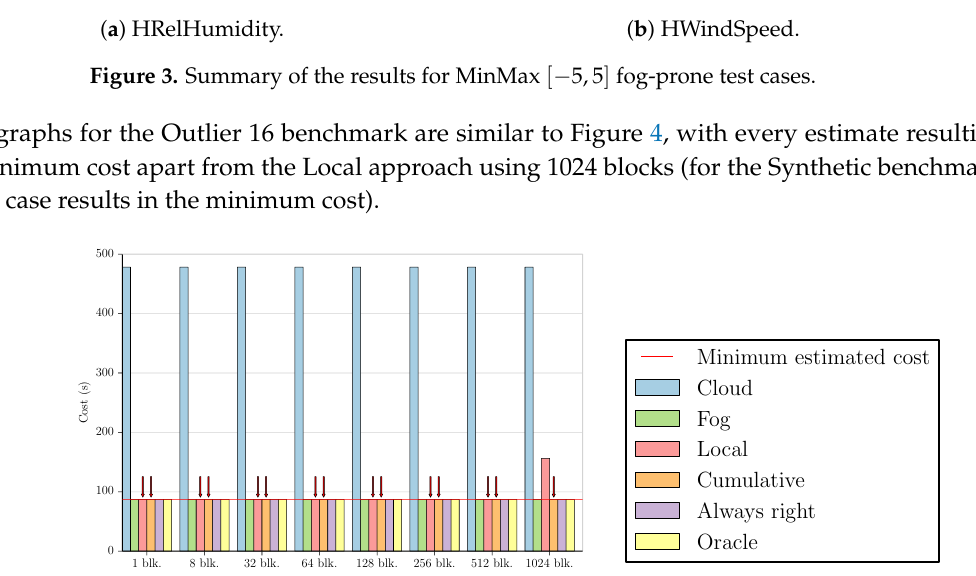
Figure 4. Summary of the results for Outlier 16 fog-prone test cases (HVisibility).